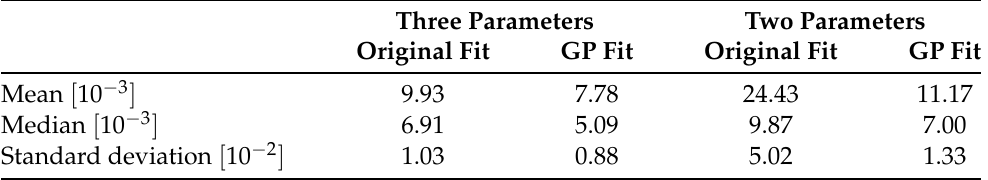
Table 2. List of the statistical parameters of the MSE distributions shown in Figure 12. Three